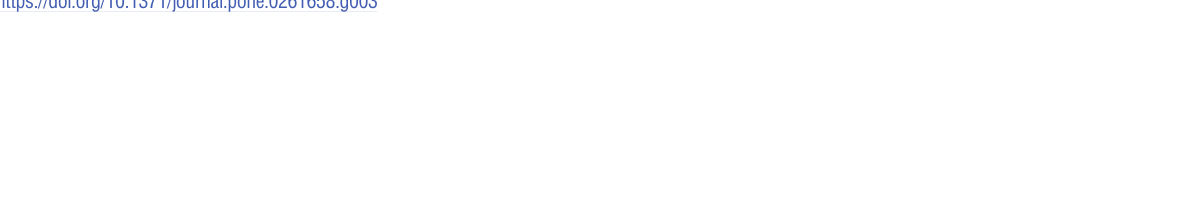
PLOS ONE | https://doi.org/10.1371/journal.pone.0261658 December31, 2021 12 /